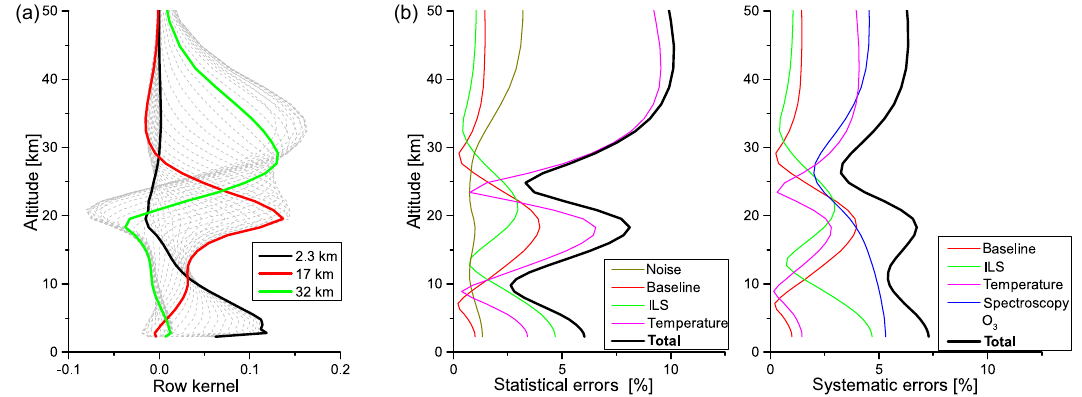
Figure 5. Same as Fig. 3, but for the profiles obtained from the medium-resolution FTIR measurements at UNAM as shown in Fig.